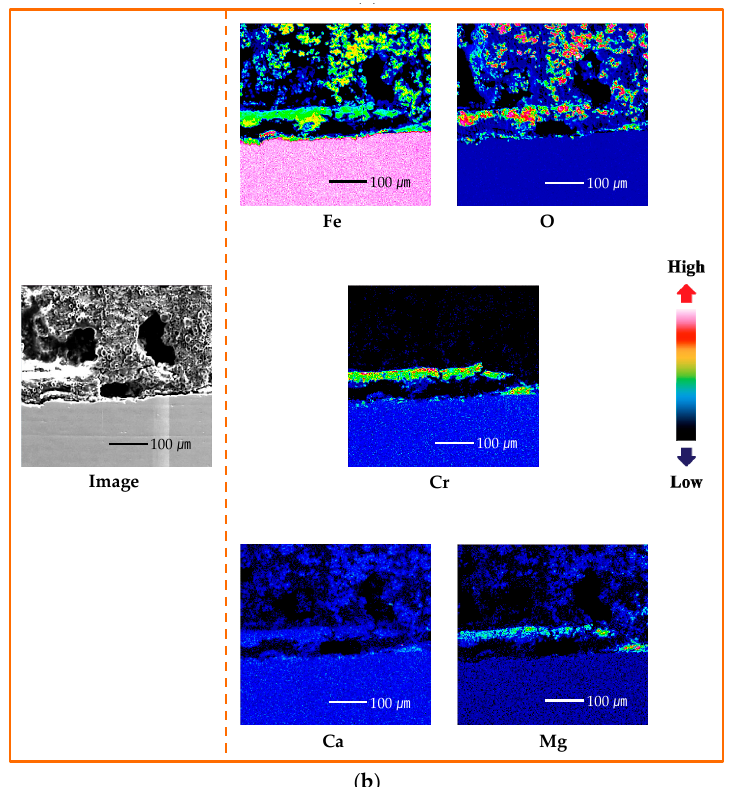
Figure 1. Electron probe microanalyzer (EPMA) cross-sectional mapping results of specimens after 30 days immersion in seawater with Mg 2+ ions: ( a ) blank steel and ( b ) 0.7-wt.%-Cr